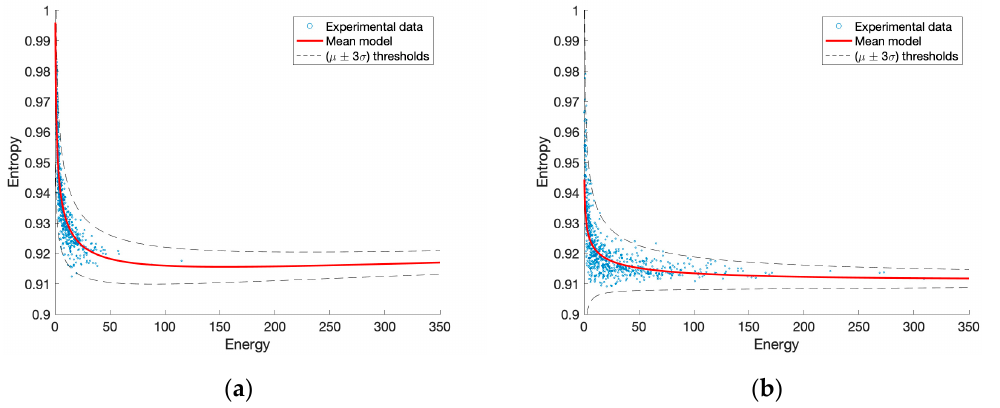
Figure 13. Entropy–energy dispersion, mean model and thresholds for a building complex near San Giovanni station: ( a ) period from 2011 to 2015; ( b ) period from 2015 to 2019. Giovanni station: ( a ) period from 2011 to 2015; ( b ) period from 2015 to